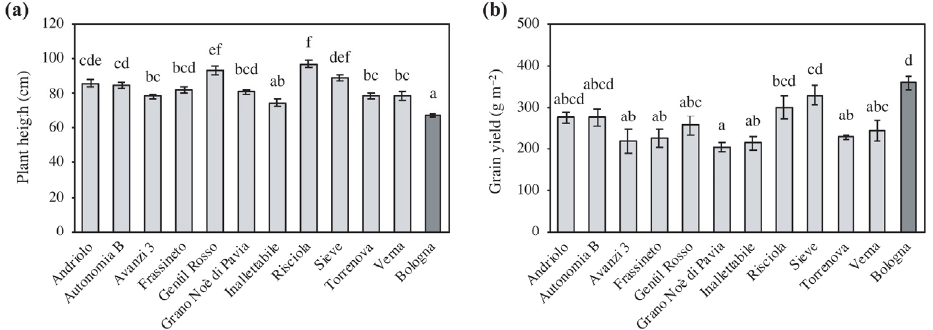
Figure 4. E ff ects of wheat genotype on plant height ( a ) and grain yield ( b ).